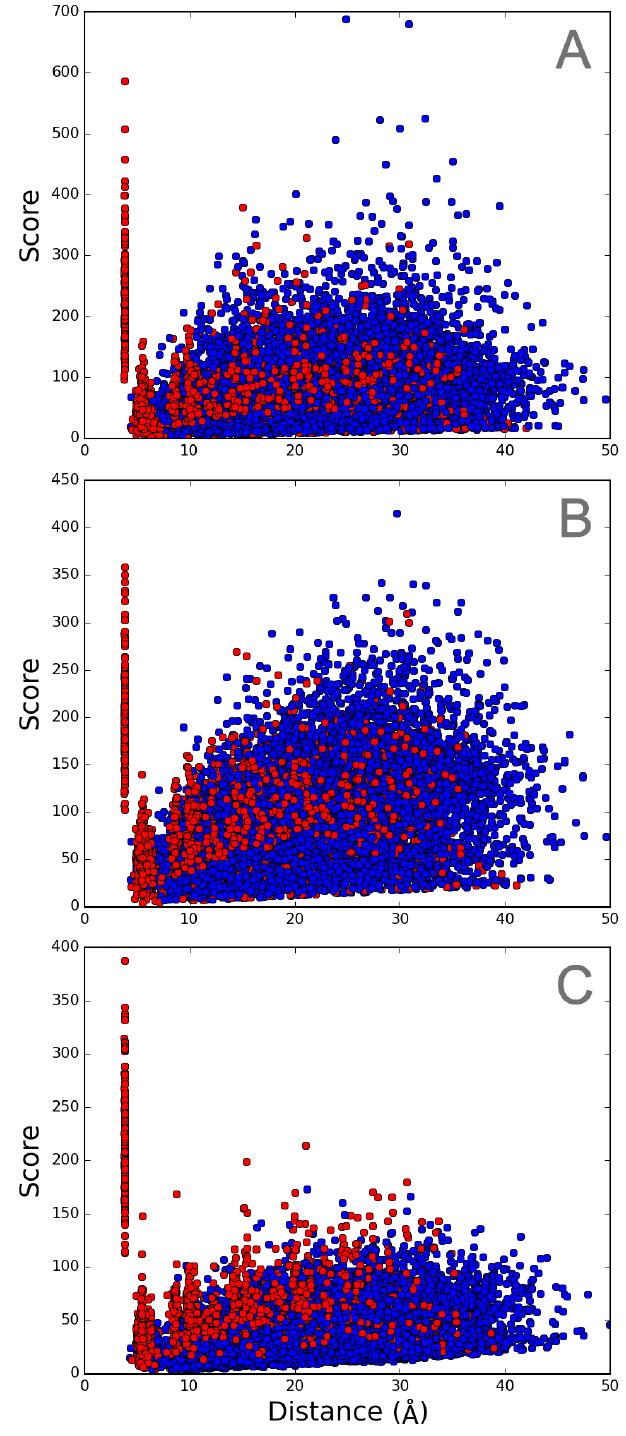
Figure 2. Correlation between score and the average distance for the 14,365 C −C pairs. A . set 1, B . set 2, and C . set 3. α α Intrahelical and interhelical C −C pairs are colored in red and blue, α α